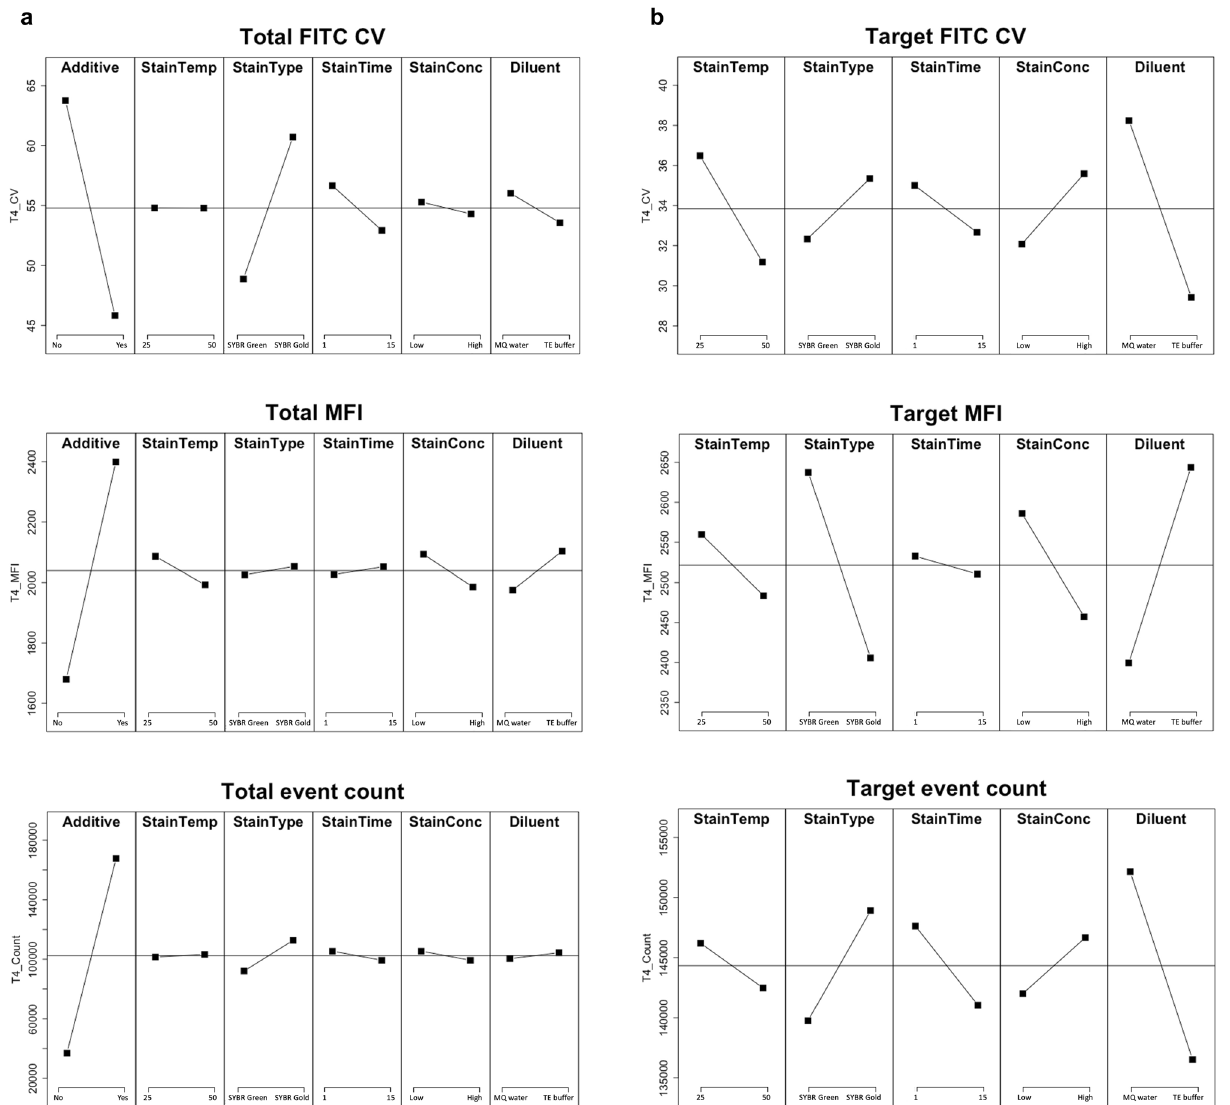
Fig. 2 Main effects plots showing optimization results. Panel a plots show all events within analysis bounds. Panel b plots show only target events in the T4